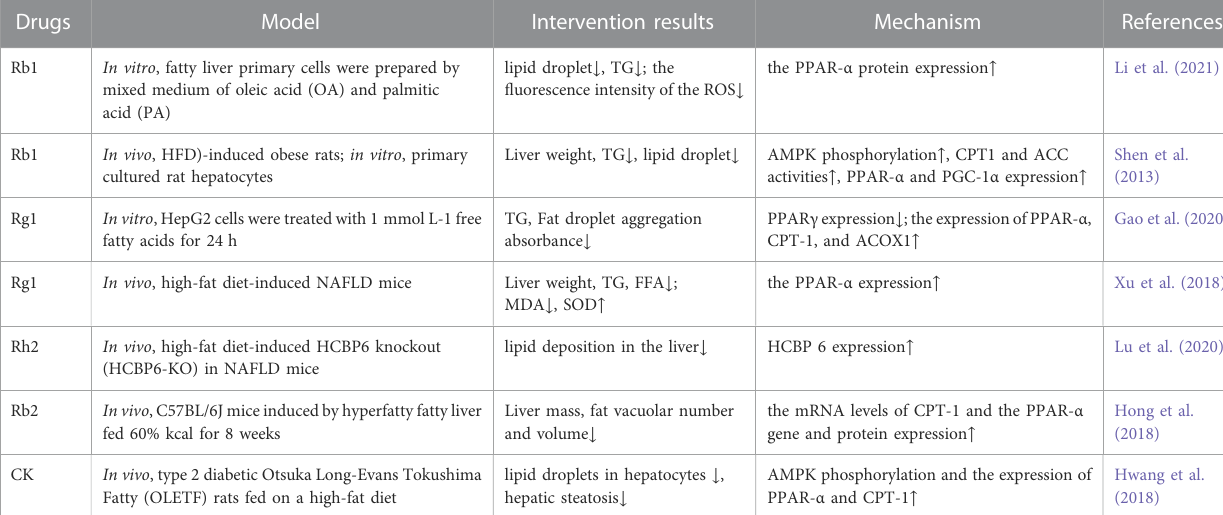
TABLE 3 Ginsenosides promote fatty acid oxidation, reduce oxidative stress, and protect organs and tissues.